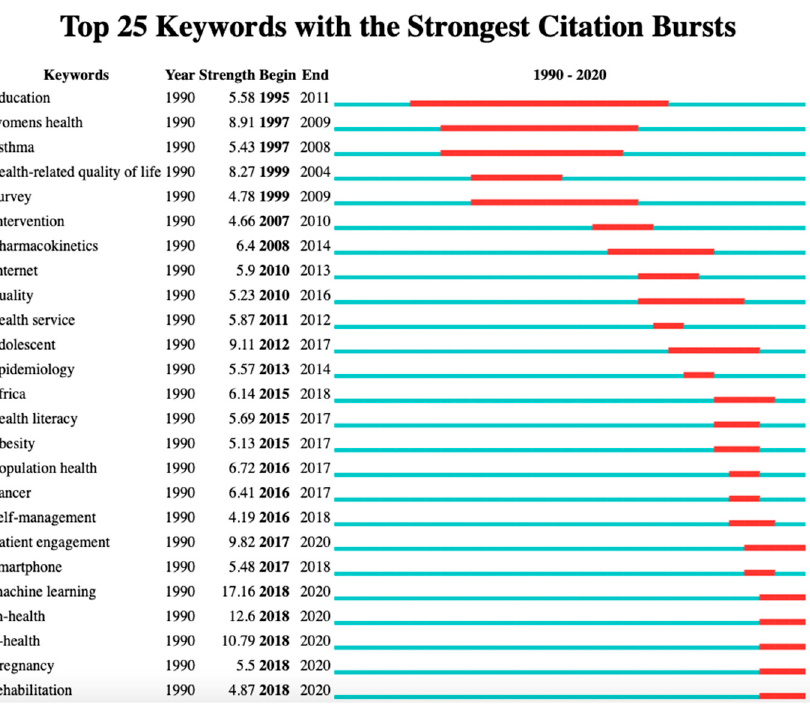
Figure 6. Health technology keywords with the strongest citation bursts.